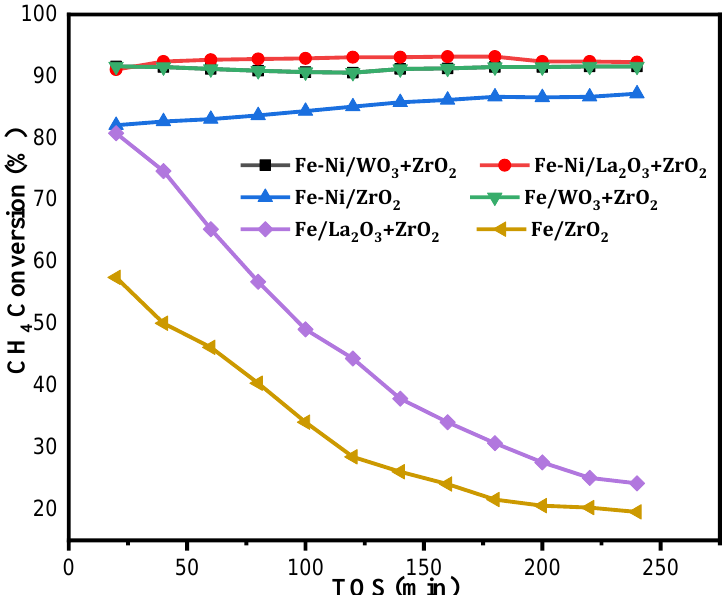
Figure 5. CH 4 conversion of Fe [22], Fe-Ni / x-ZrO 2 (x = 0, La 2 O 3 , WO 3 ) at the operating conditions of 1 atm, 800 °C, and 4000 mL(hg cat ) −1 .